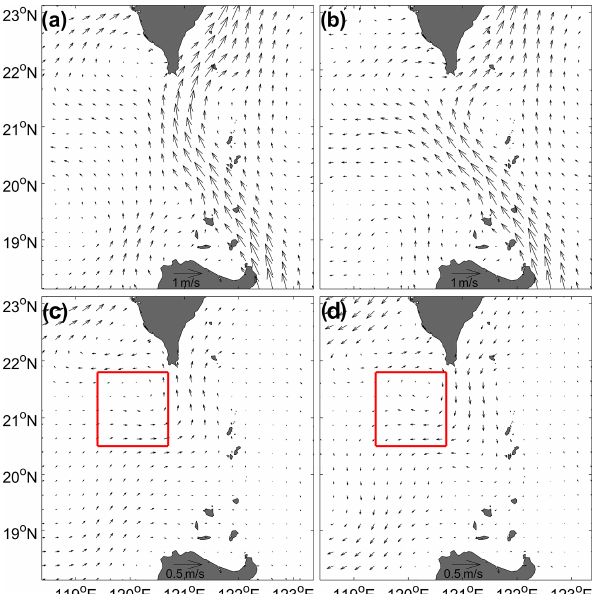
Figure 5. Climatic distributions of geostrophic current in May and June (a) and in December and January (b) , and of geostrophic cur- rent anomaly in May and June (c) and in December and January (d) . Red boxes in (c) and (d) outline 20.5–21.8 ◦ N, 119.4–120.7 ◦ E, which represent the position of mesoscale eddies on west side of LS. Figure based on CMEMS